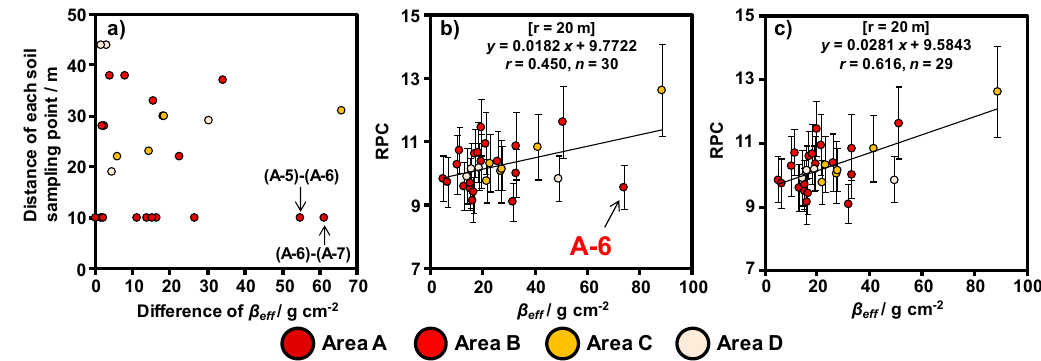
Figure 10. Conceptual schema showing the process for removing irregular data from the 20 m agl. dataset. ( a ) Relationship between the distance of each soil sampling points and the difference in β eff ; ( b ) relationship between RPC and β eff before the removal of the irregular data; and ( c ) relationship between RPC and β eff after the removal of the irregular data.